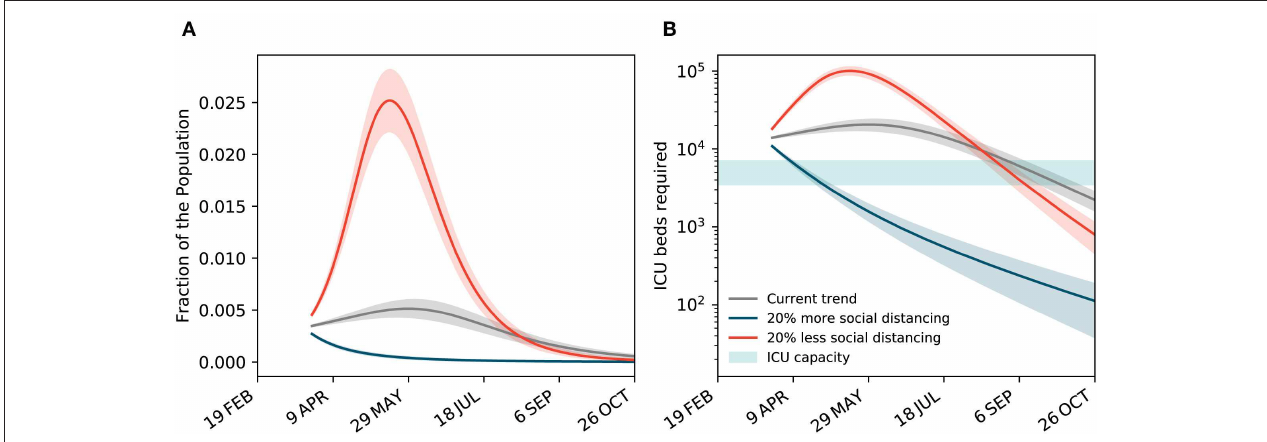
FIGURE 5 | Scenario analysis for maintaining, reinforcing, or easing the restrictions. (A) The projected curves for the total number of confirmed and suspected cases under three different scenarios: maintaining the same level of control measures as of 12 April 2020, reinforcing the control measures to increase physical distancing by a 20% increase in the reproduction number, and partial lifting the restrictions to ease physical distancing by a 20% decrease in the reproduction number. (B) The projected number of ICU beds needed under the three scenarios. The original ICU capacity is assumed between 3,500 to 7,000 beds